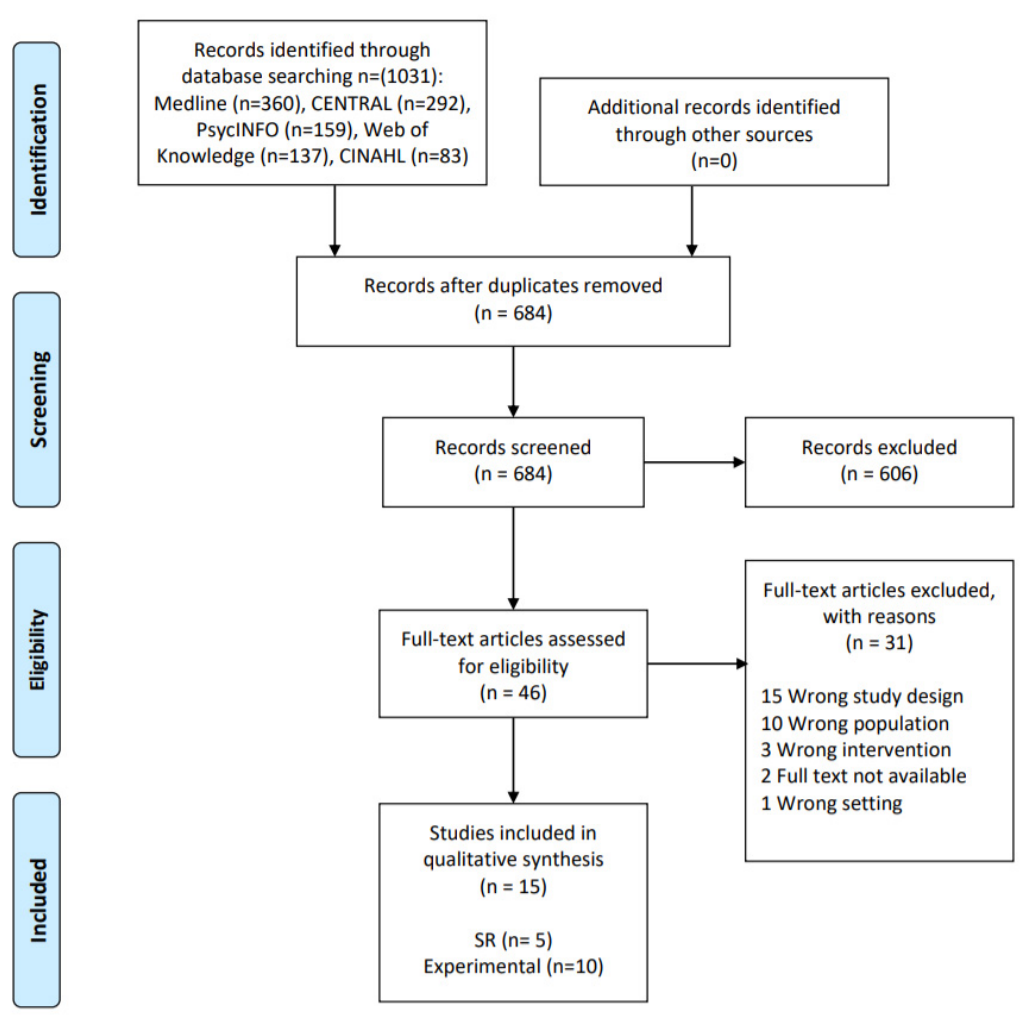
Figure 1. Flow diagram of study selection